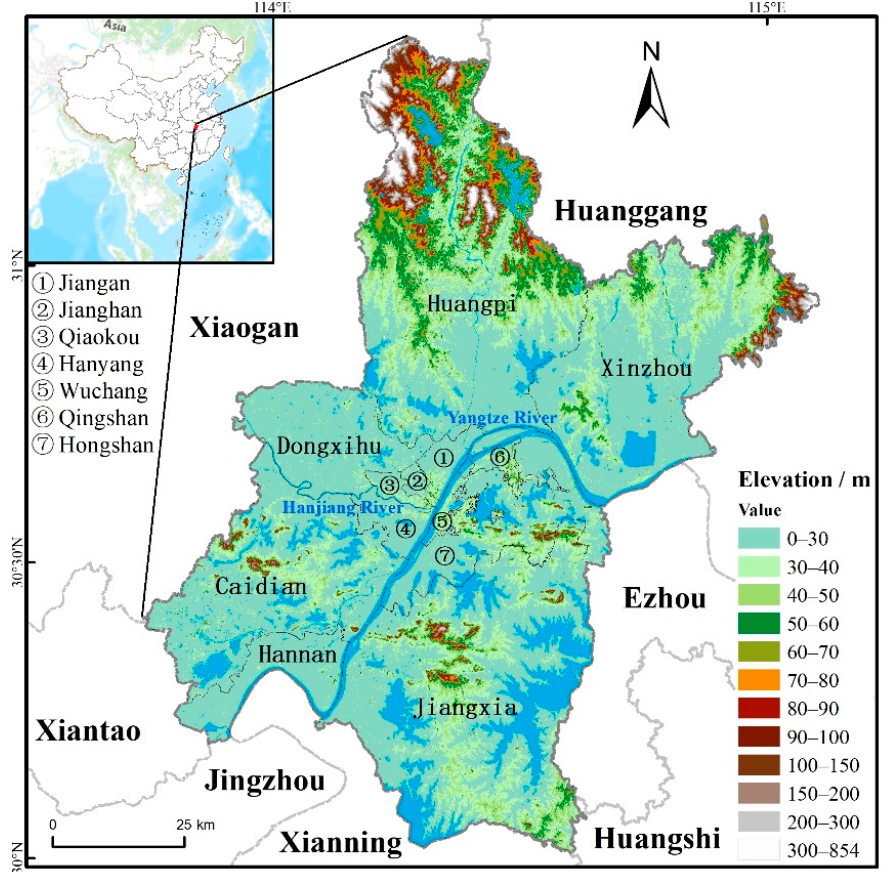
Figure 1. Location of Wuhan city.